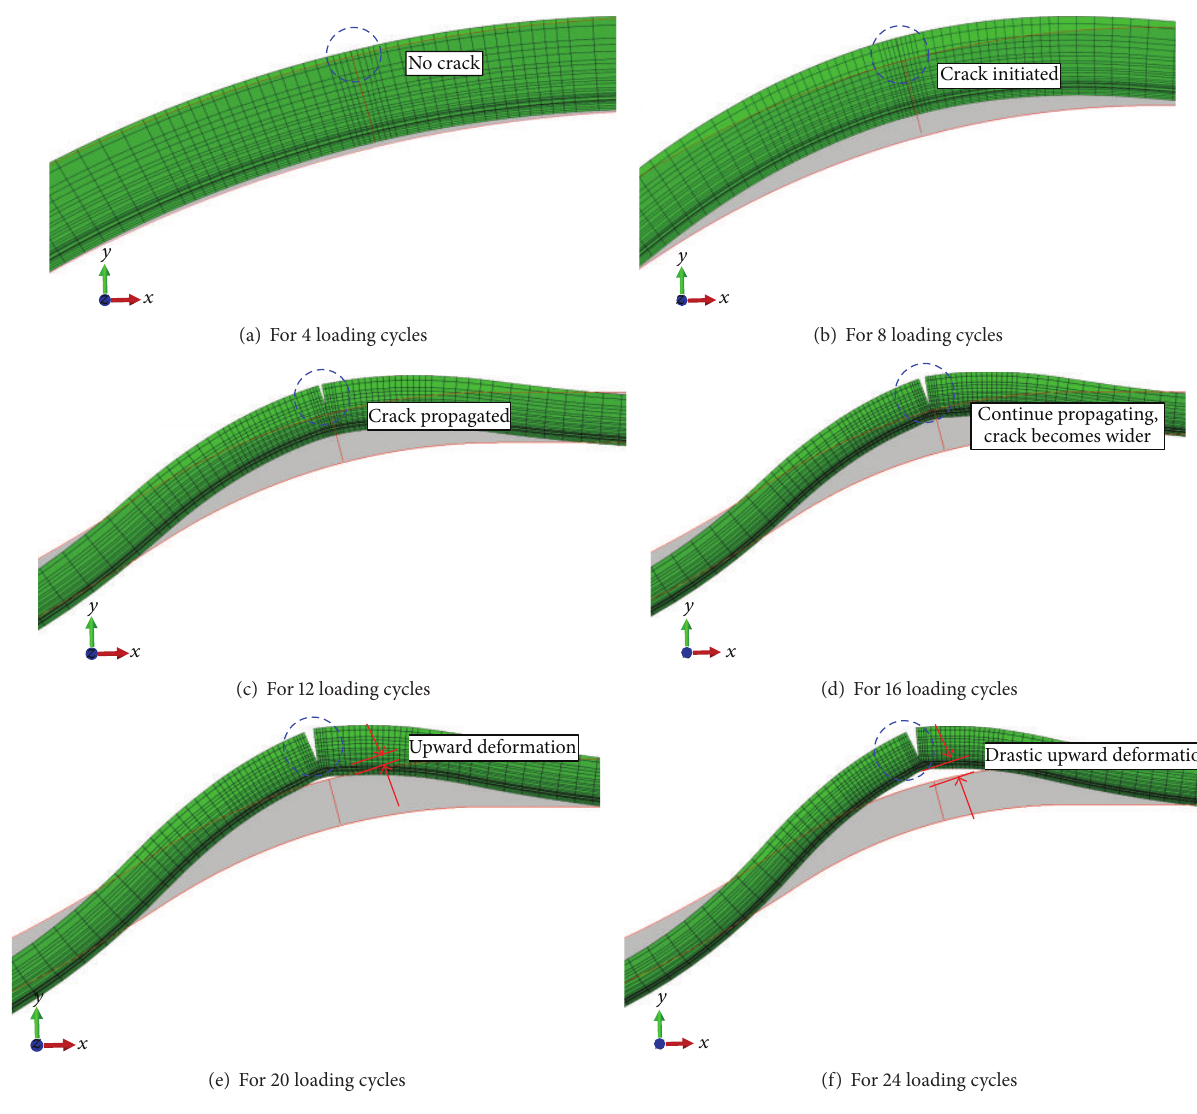
Figure 14: TGO deformation indicating crack propagation upon twenty-four loading cycles: (a) for 4 loading cycles, (b) for 8 loading cycles, (c) for 12 loading cycles, (d) for 16 loading cycles, (e) for 20 loading cycles, and (f) for 24 loading